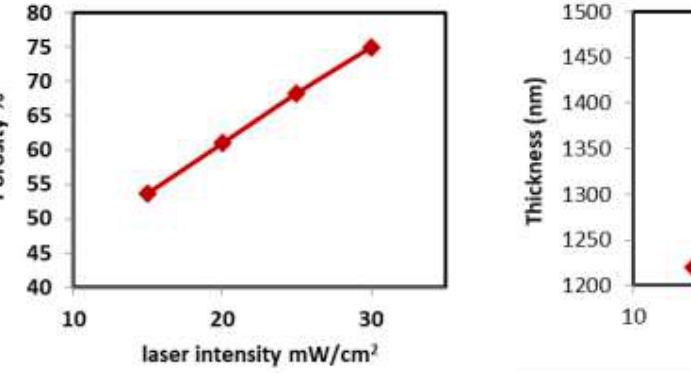
Figure 2: Porosity vs etching laser intensity. Figure 3: layer thickness vs etching laser